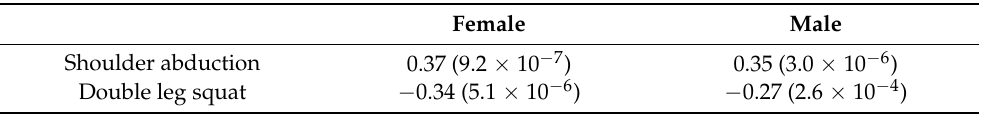
Table 7. Spearman’s rank correlation coefficients ( p -values) to assess statistical dependence between the rankings of survey responses and physical achievements by